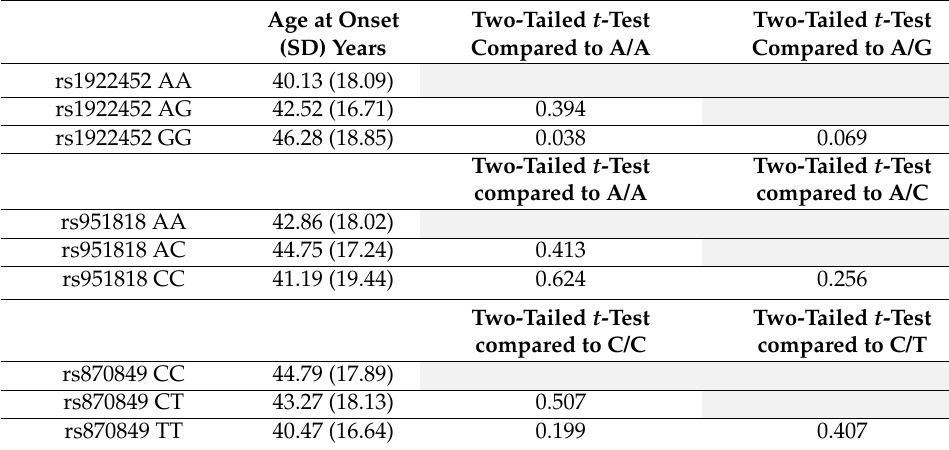
Table 3. Age at onset of RLS according to the genotypes.